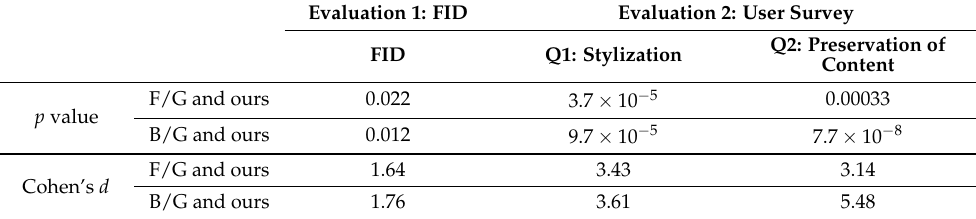
Table 3. Analysis of the evaluation